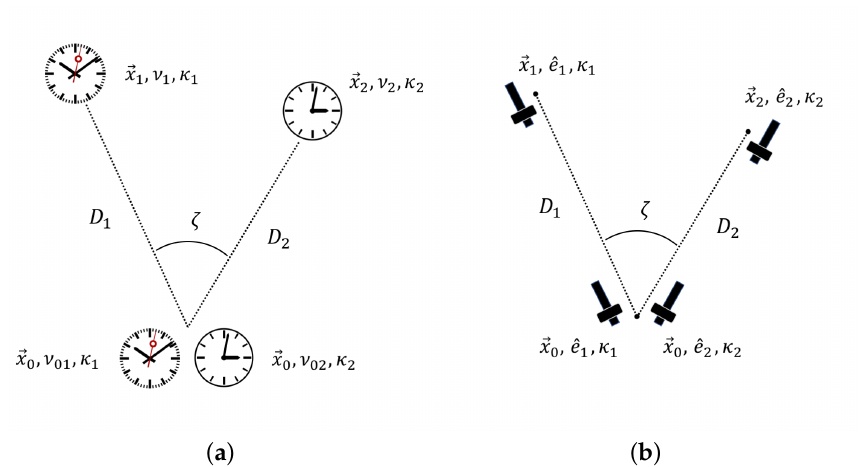
Figure 1. ( a ) Triangle-shaped configuration of two pairs of identical clocks. Frequencies and sensitivities to DM are denoted by ν i and κ i , respectively; ( b ) Triangle-shaped configuration of two pairs of identical atom interferometers pointing in radial direction (each direction is denoted by ˆ e i ). The length of the first and the second arm is denoted by D 1 and D 2 ,